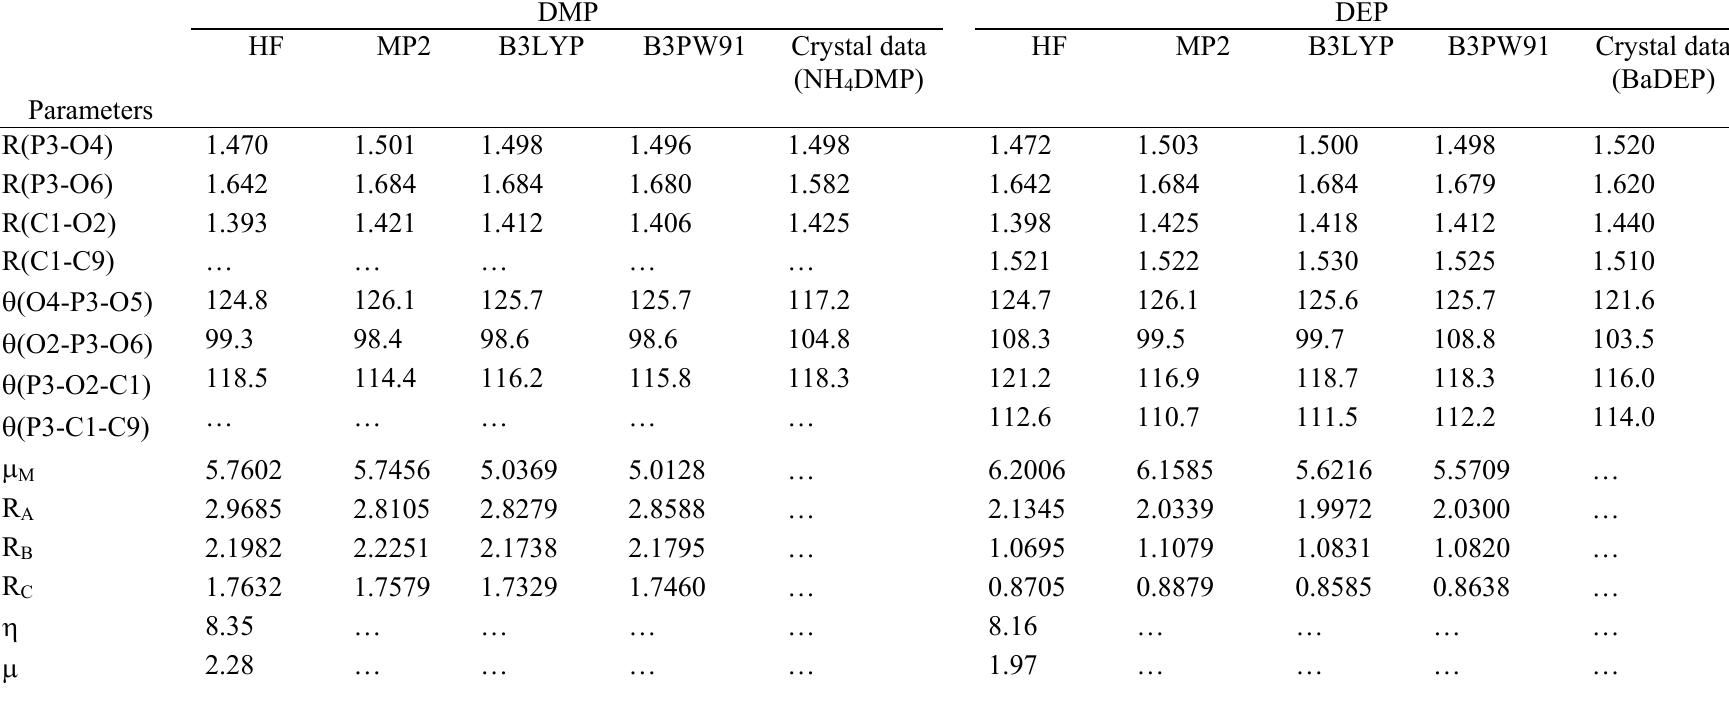
Table 1. Optimized geometrical parameters (bond length in Å, bond angle in degrees), rotational constants R Debye), chemical potential µ (in eV) and chemical hardness η (in eV) for DMP and DEP